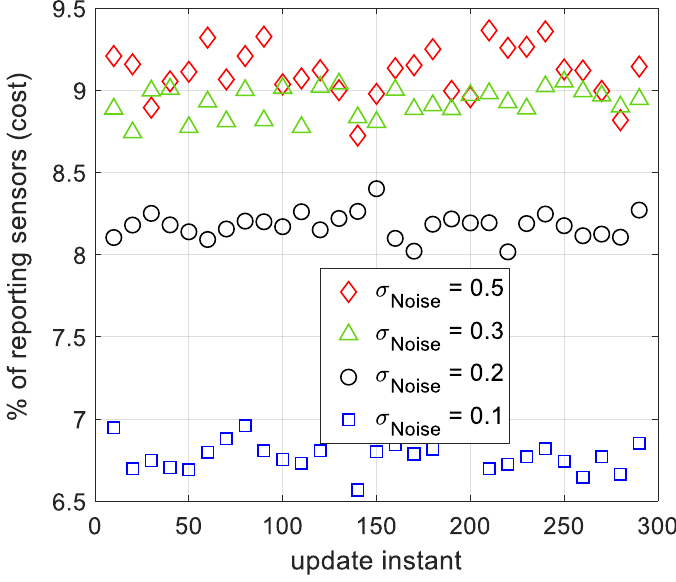
Figure 8. The tracking cost of SSG for several filtered observation noise strengths, during several tracking instances. The sensors apply moving average filter on their local observations to reduce the effect of additive